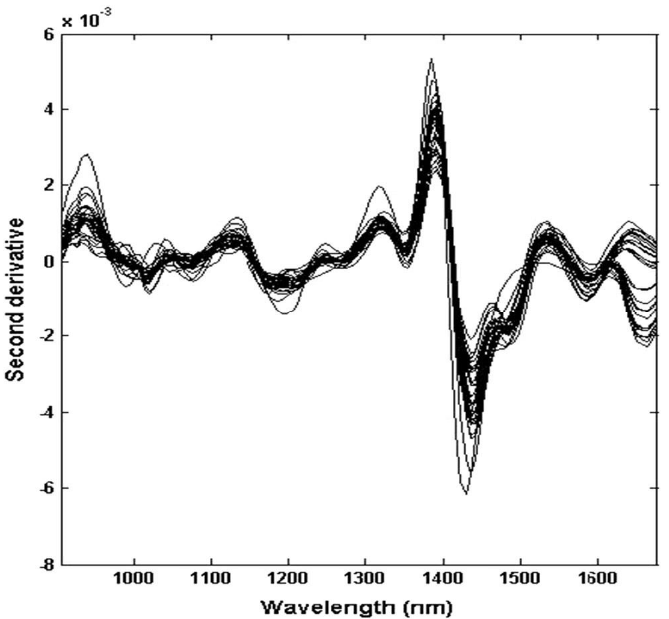
Figure 4. NIR spectra of all honey samples. (Reprinted with permission from ref [36]). The results obtained using PCA from NIR spectroscopy were identical to those from the ComDim multiblock analysis (“Common Dimensions”), so it is easier to replace the physico chemical parameters determination by NIR spectroscopy in the honey sample discrimination [37,38]. In another study, four unique varieties of honey (saffron, apple, cherry, and Plectran- thus rugosus ) from the Kashmir valley of India were studied, taking into account the prin- cipal physico-chemical parameters and carbohydrate profile [39], obtained in the region 1400 to 750 cm − 1 , which corresponds to the most sensitive absorption region of the sugars by using FTIR–ATR. A representative ATR-FTIR spectrum of saffron honey is presented in Figure 5.